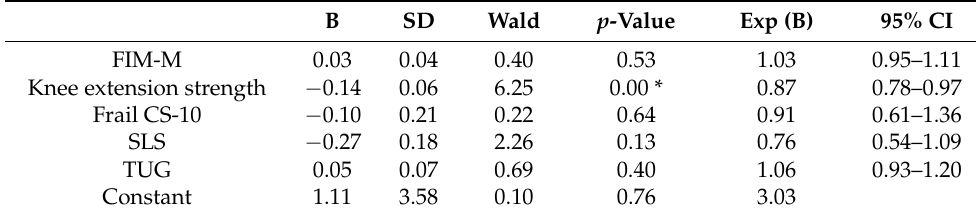
Table 3. Results of logistic regression analysis.